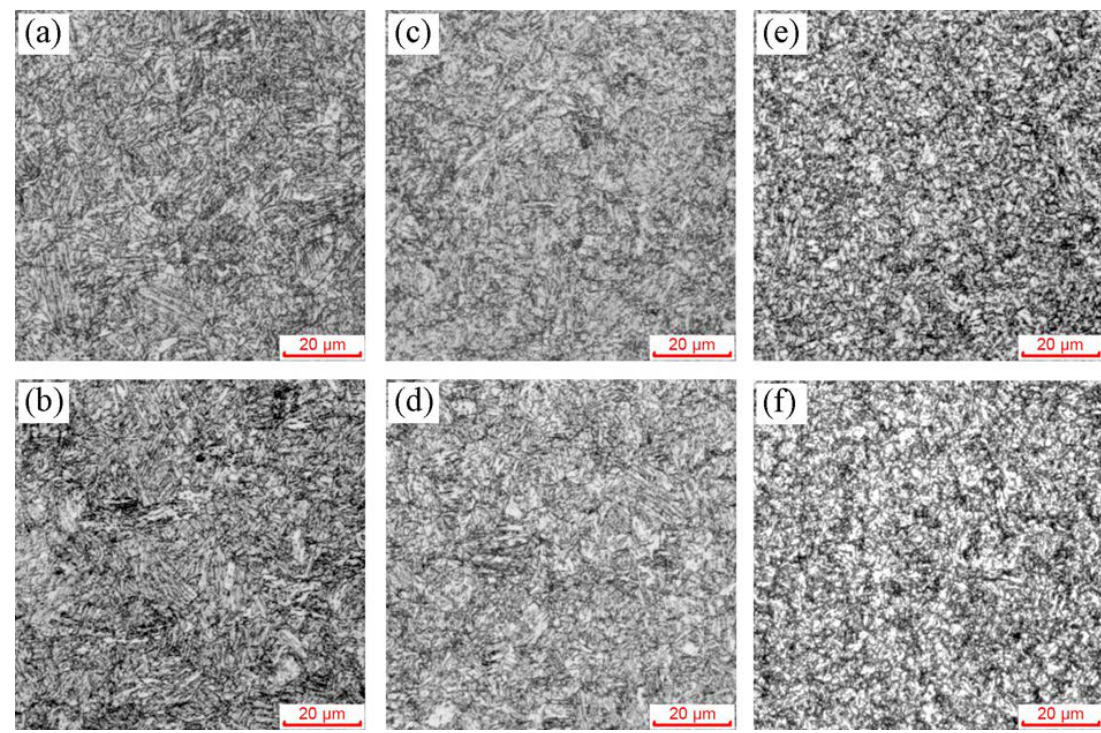
Figure 6. OM micrographs of three steels after two-step Q&P treatment: ( a , b ) 0V, ( c , d ) 0.03V, and ( e , f ) 0.16V, partitioned for ( a , c , e ) 90 s and ( b , d , f ) 200 s.